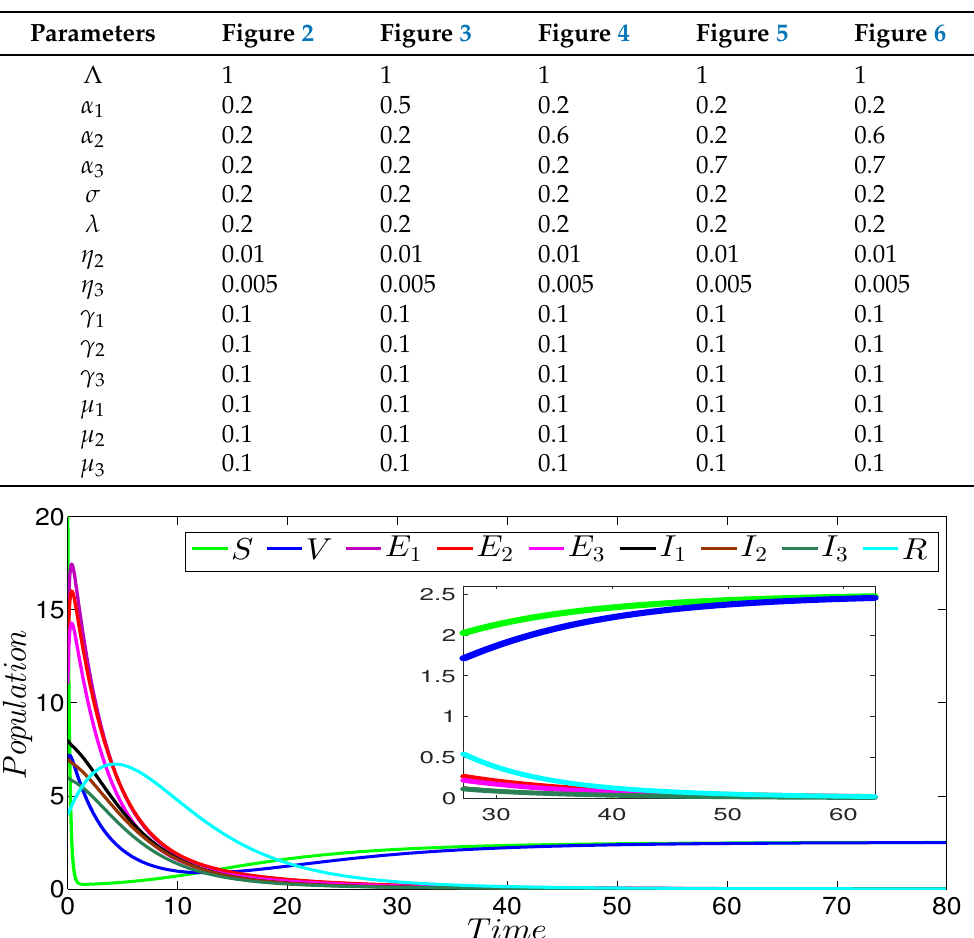
Table 2. The parameter values of system (1) .